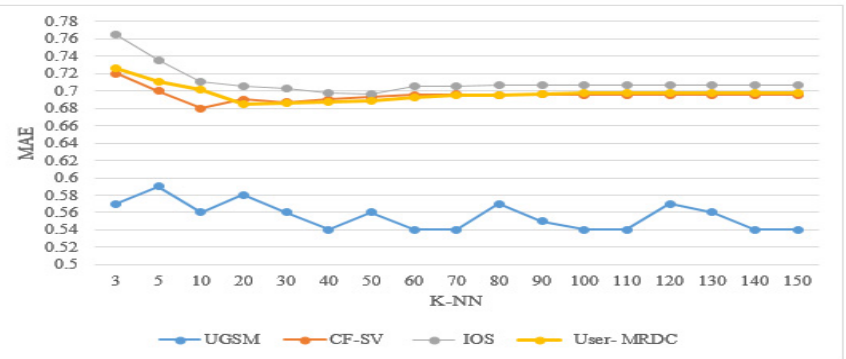
Figure 7. Comparison of the UGSM’s accuracy to the state-of-the-art algorithms for the ML1 da- taset. The X -axis is the K-NN and the Y -axis is the MAE value.